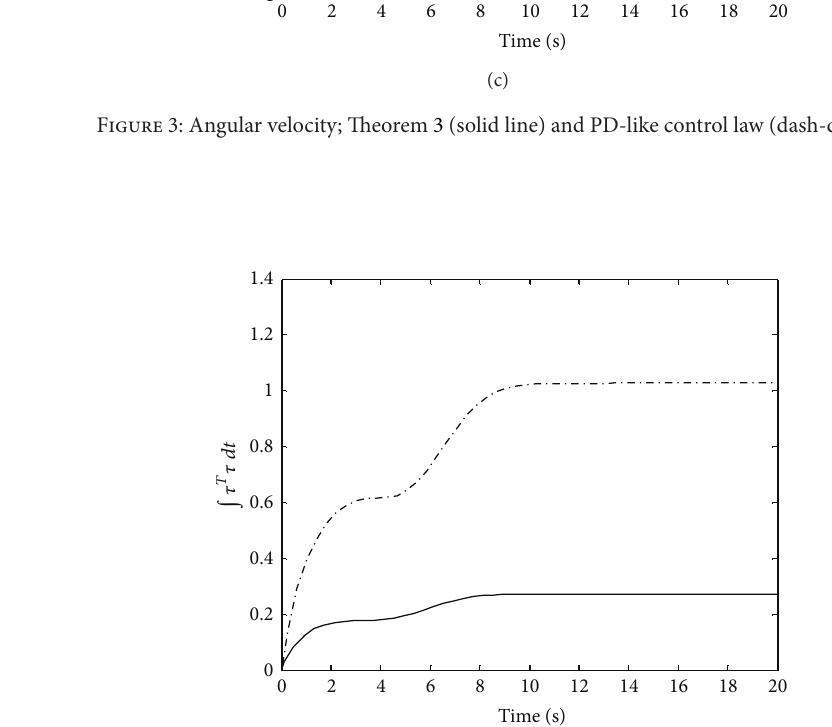
Figure 4: Energy consumption; Theorem 3 (solid line) and PD-like control law (dash-dot